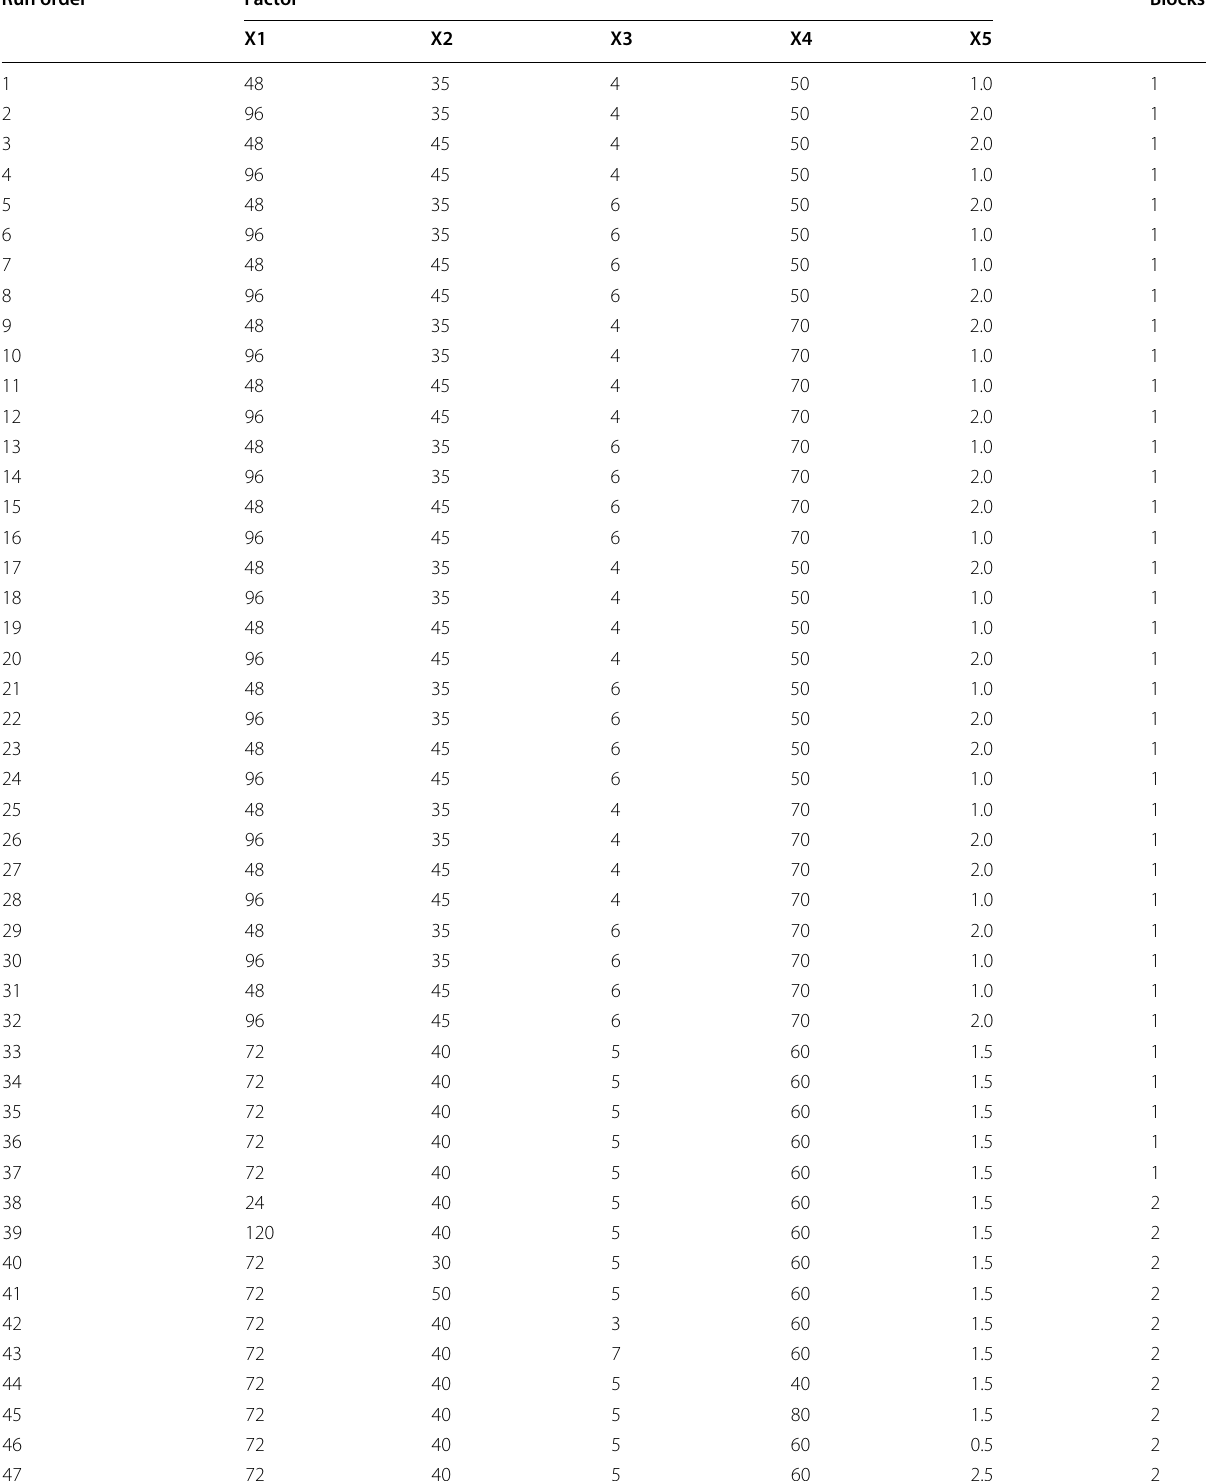
Table 2 The experimental runs of CCD for optimization of protease production Run